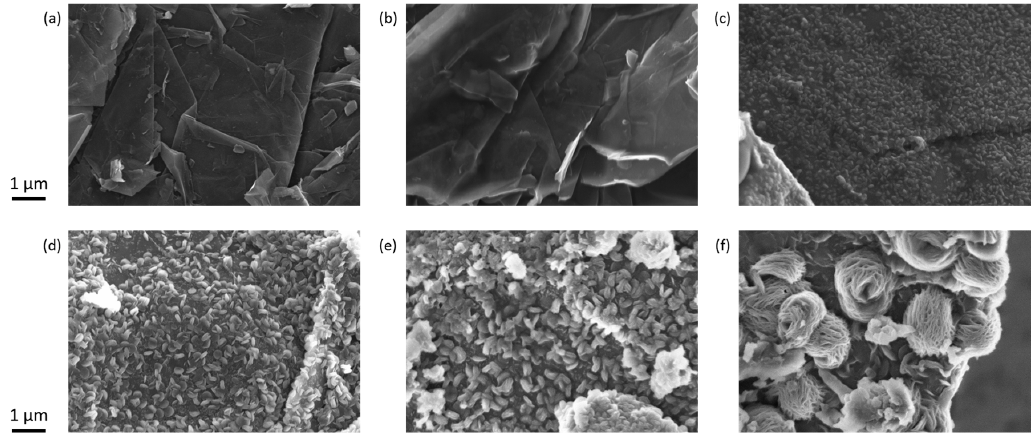
Figure 2. SEM images of discharge products on GNS obtained after full discharge at various rates. All images were taken from GNS at the electrode top (O 2 -rich side). ( a ) Pristine GNS for reference. Discharged GNS samples with current densities of ( b ) 1.5 mA/cm 2 , ( c ) 500 µA/cm 2 , ( d ) 150 µA/cm 2 , ( e ) 50 µA/cm 2 and ( f ) 15 µA/cm 2 . See Figure 1 for the respective discharge capacities.